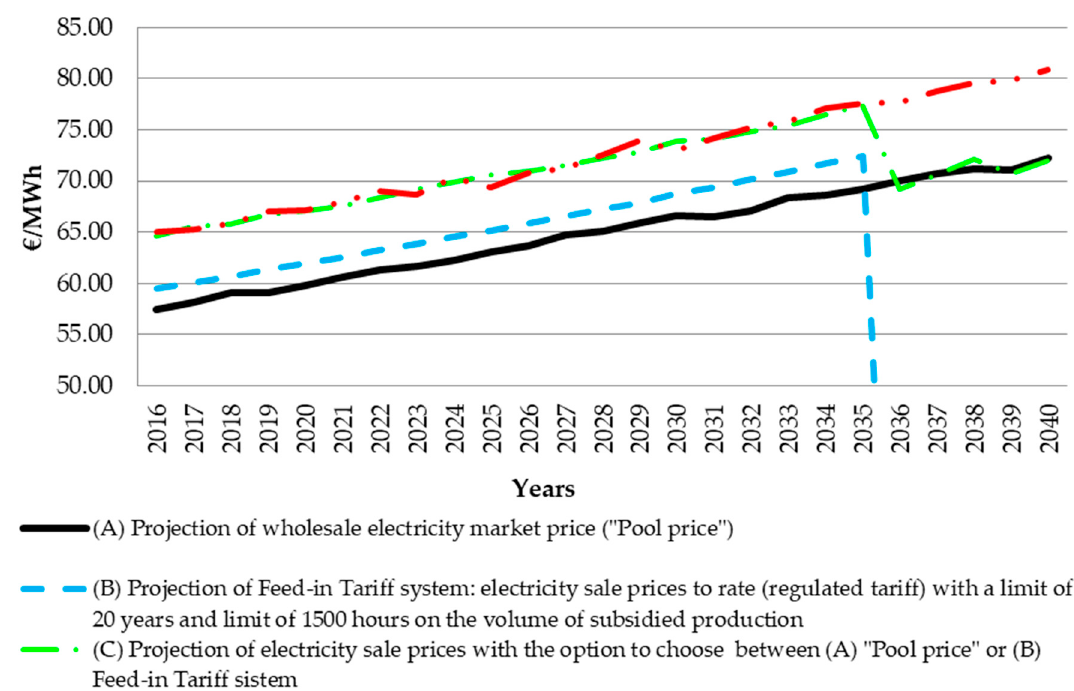
Figure 2. Simulated evolution of remuneration methods for the photovoltaic park. Source: Own elaboration.